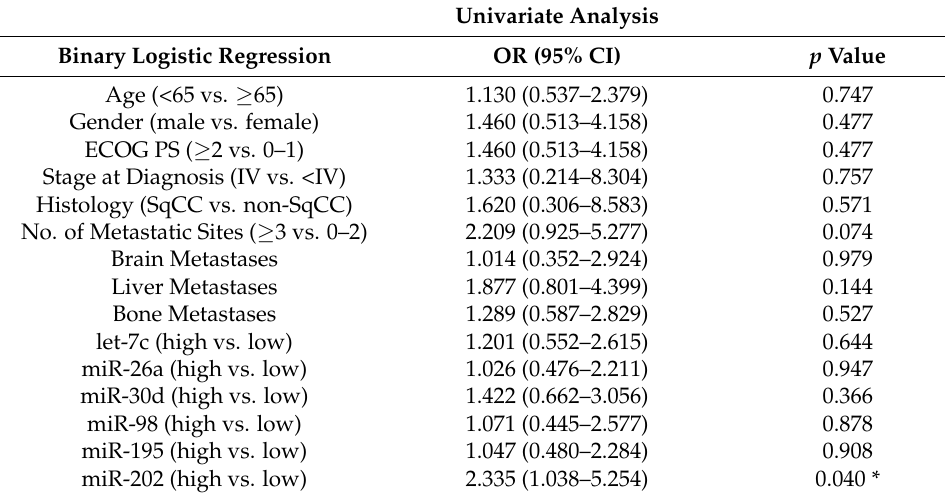
Table 2. Binary logistic regression analysis depicting the odds ratios of the study parameters based on the probability of developing progressive disease as a response to platinum-based chemotherapy in NSCLC patients (N =